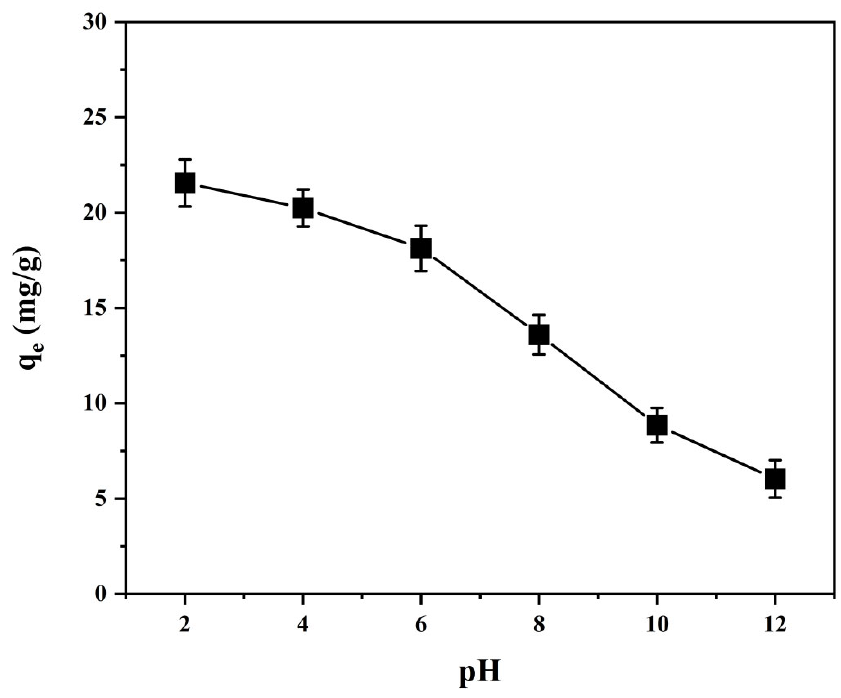
Figure 7. Effect of pH on the SO 42 − adsorption capacity of HNM ‐ 4.